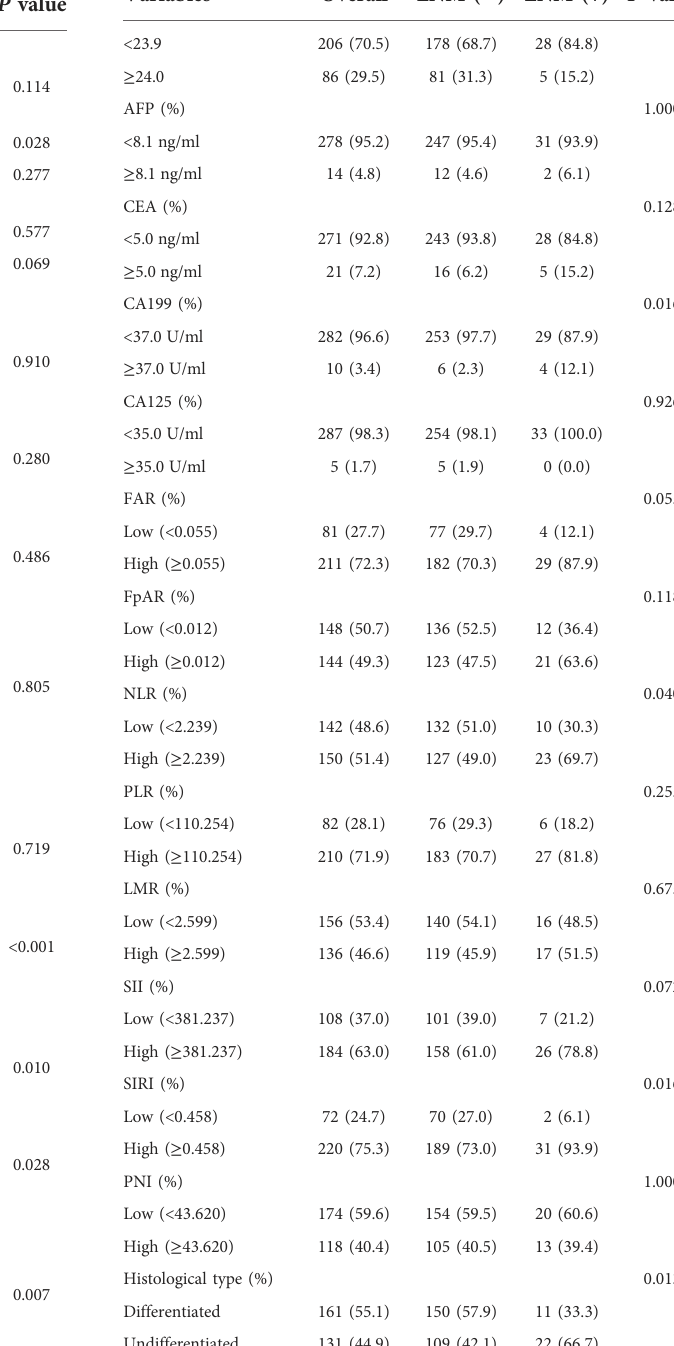
TABLE 1 Univariate analysis of preoperative clinicopathological